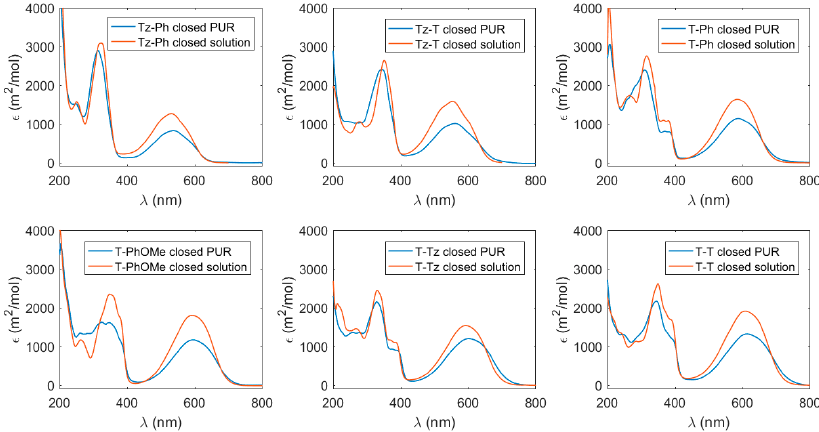
Figure 3. Molar extinction coefficients for the closed-ring forms (colored) of the investigated monomers dissolved in ethanol (red line) and after polymerization (PU film, blue line).